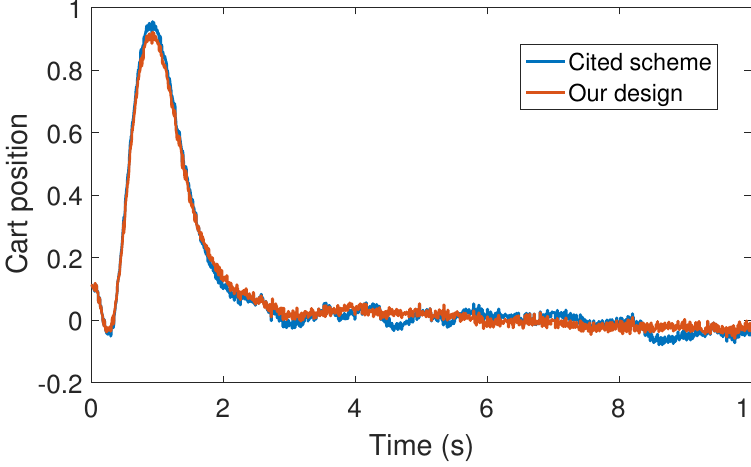
Figure 7. Numerical experiment results(noisy case): cart position